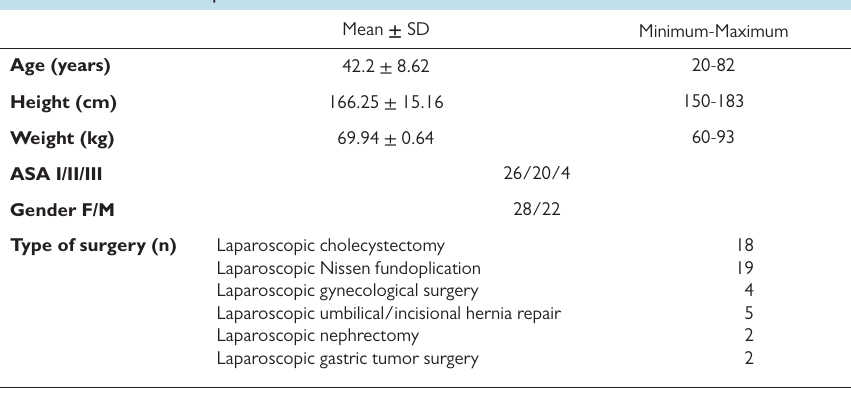
Table 1. Patients Descriptive